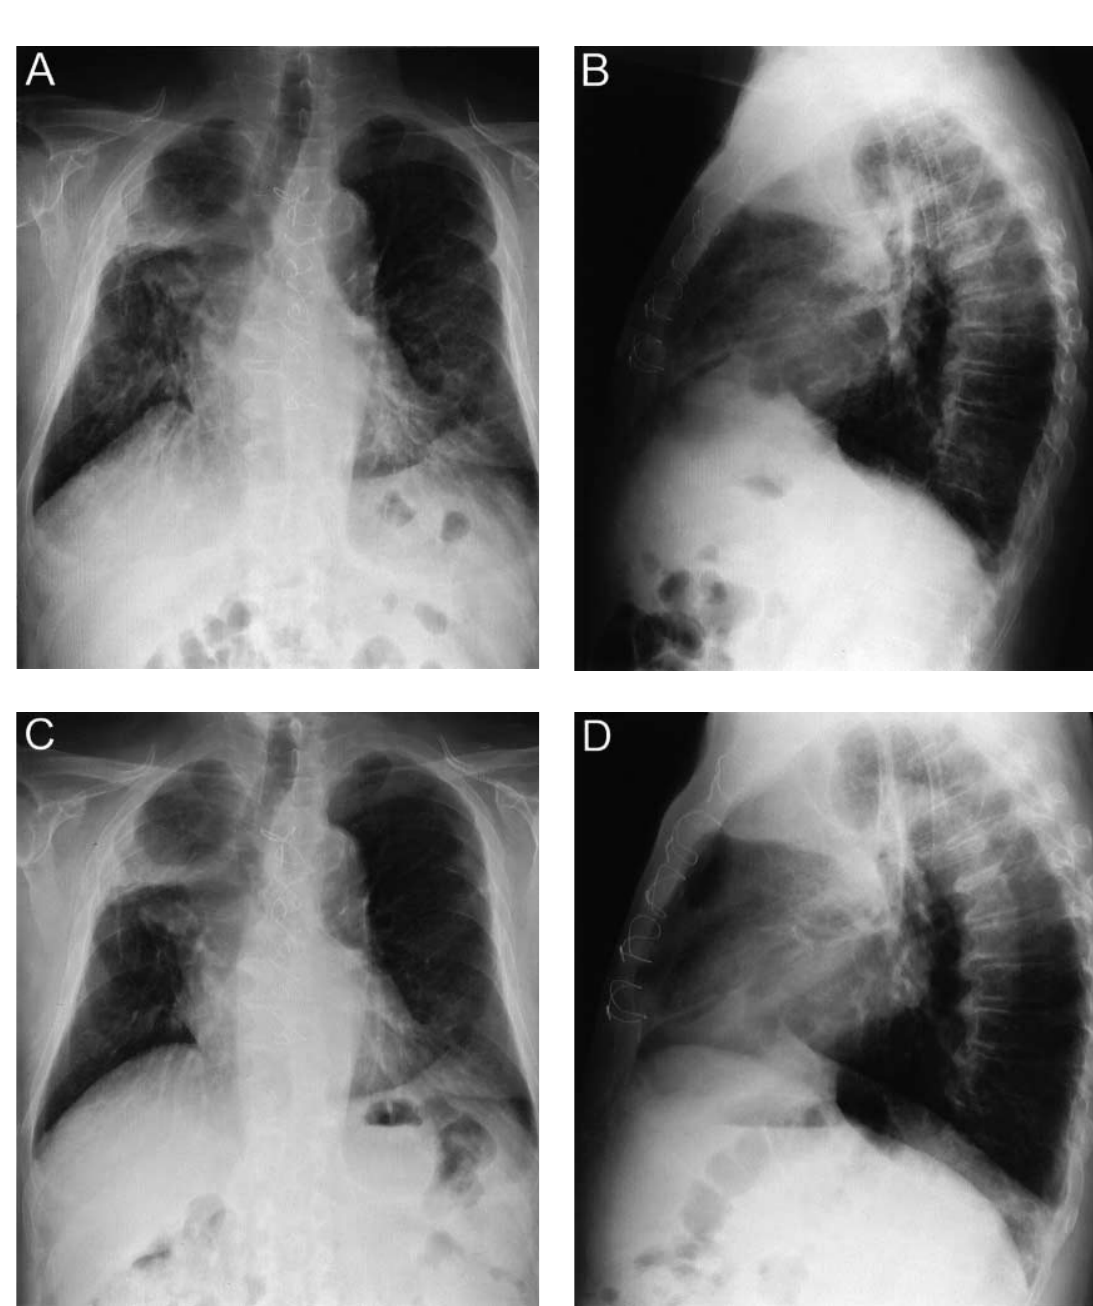
A: Chest X-ray of case 1 showing bilat- eral predominantly reticulo-nodular interstitial infiltrates, increased density of the bronchovascular bundle and bilateral pleural effusions. B: Almost complete resolution of the radiographic abnormalities.